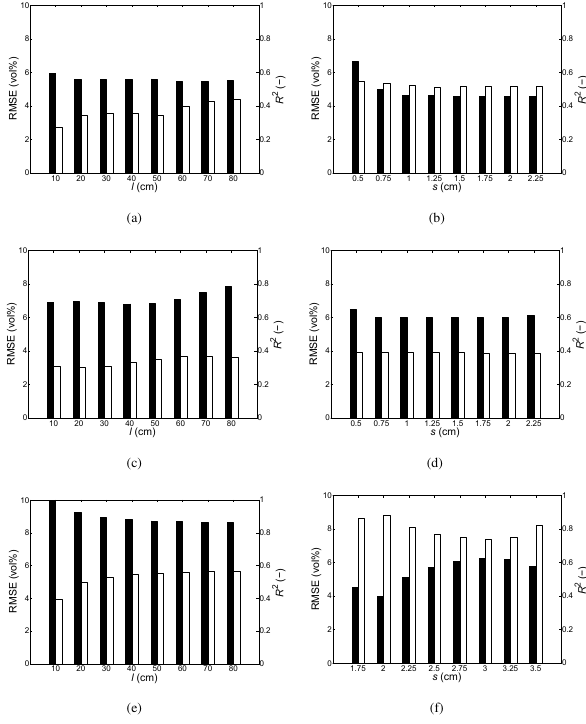
Fig. 10. Soil moisture retrieval performance in terms of RMSE (black) and R 2 (white), based on fixed correlation lengths (left) and fixed RMS heights (right) at C-band HH (top), C-band VV (middle) and L-band HH (bottom) configuration.